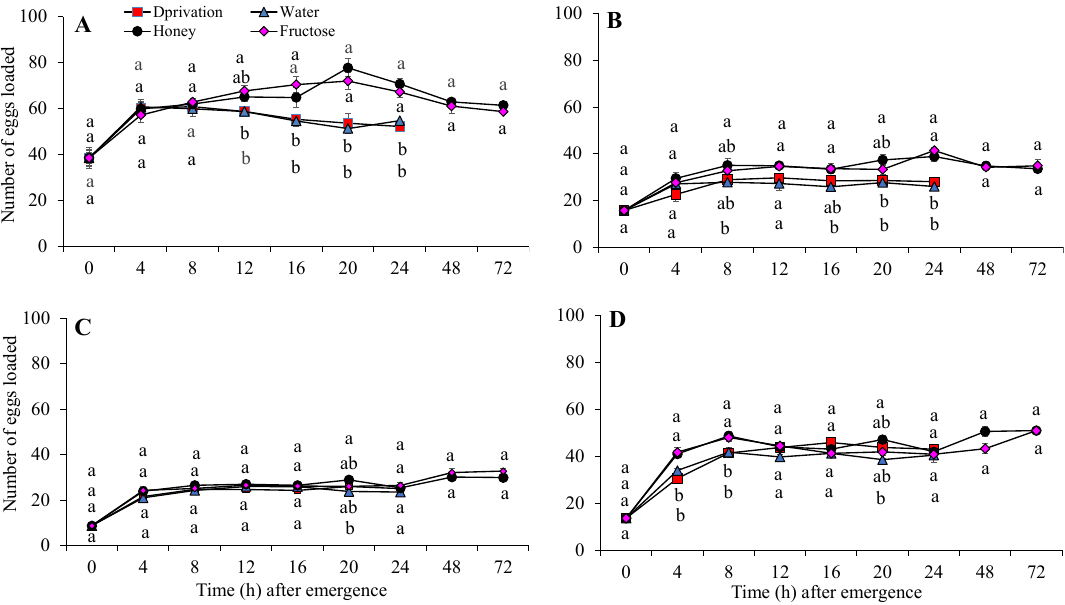
Figure 2. Impact of carbohydrate-rich diet on the egg maturity of four Trichogramma species with time. T. dendrolimi ( A ), T. chilonis ( B ), T. leucaniae ( C ), and T. ostriniae ( D ). Number of mature eggs